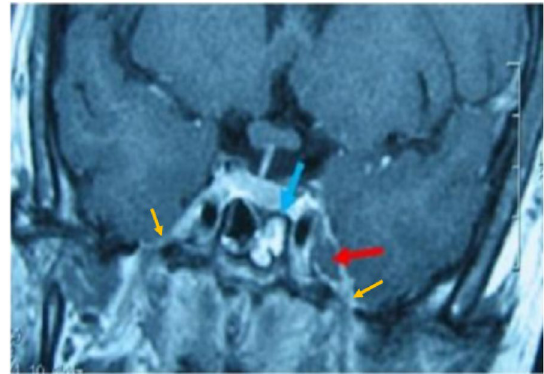
Fig. 7 Case 7. Left acute invasive fungal sinusitis with cavernous sinus thrombosis. MRI T1 gadolinium-weighted sequence coronal view showing a total filling of the left sphenoid sinus (blue arrow) with homolateral cavernous sinus thrombosis (red arrow) and skull base pachymeningitis (yellow